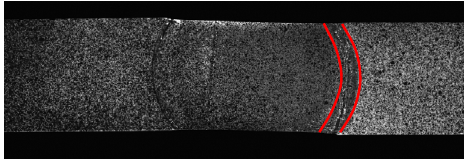
Figure 7: Reference lines for the recovery of the relative displacements during material